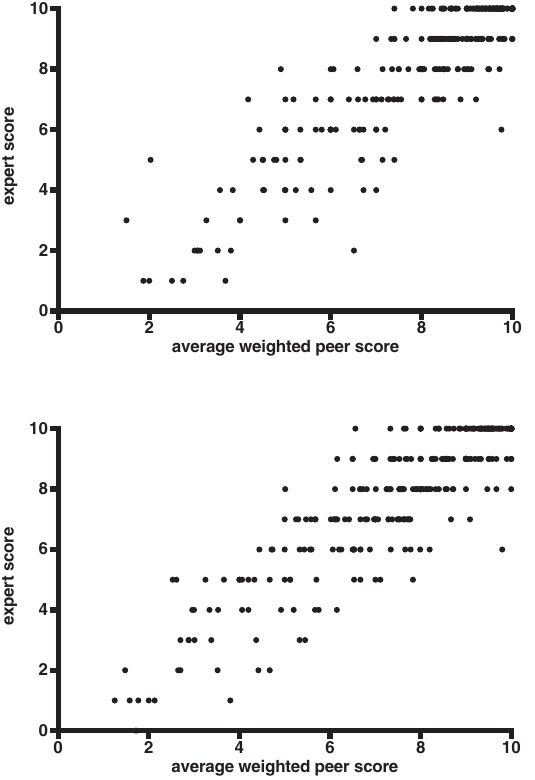
FIG. 3. Histograms of the difference between the average weighted text score and expert score on the magnetism ( N ¼ 313 , upper) and Newton ’ s second law ( N ¼ 312 , lower) CPR tasks.